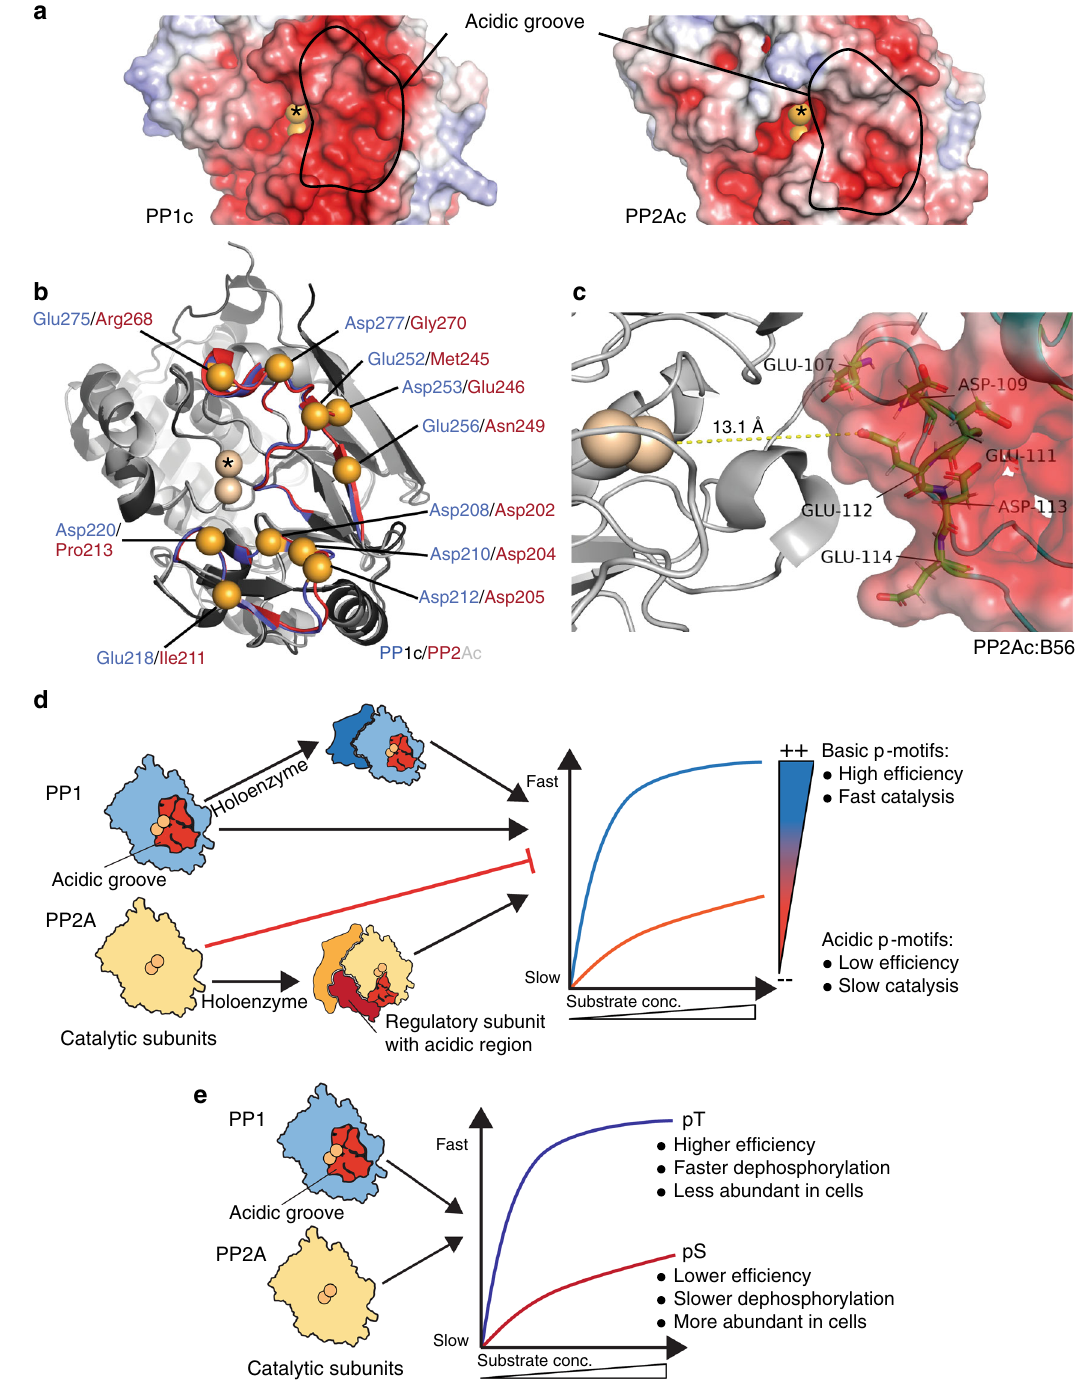
Fig. 8 Relating the amino acid preference of PP1c and PP2Ac to holoenzymes. a The acidic groove is much more pronounced in PP1c compared to PP2Ac. Structures for PP1 catalytic subunit alpha isoform (PDB ID 3EGG, chain A) 50 and PP2A catalytic subunit alpha isoform (PDB ID 4I5L, chain C) 69 were retrieved from www.pdb.org (accessed 25 Oct 2019) and inspected in PyMOL v2.3.3. * marks the catalytic cleft containing two Mn 2 + ions. Color coding between − 5 (red) to + 5 (blue) K b T/e . b Aligned structures of PP1c and PP2Ac (see above for details) highlighting residues which determine differences in acidic properties (orange spheres). The sequence alignment to determine corresponding residues was carried out in Needle (EMBOSS). Color coding of structures: PP1c in blue/black, PP2Ac in red/gray. Residues constituting the acidic groove have previously been de fi ned by Zhang et al. 70 c Interaction of PP2Ac with B56/B´/PR61 based on the crystal structure of the trimeric holoenzyme with the scaffolding subunit A (PR65) derived from PDB ID 2NPP 48 . Negatively charged amino acids within the binding regions of B56 to PP2Ac are highlighted. d The holoenzyme of PP1 has an intrinsic preference for basic motifs due to the composition of the acidic groove of the catalytic core protein. PP2A holoenzymes are per se not primed towards amino acid sequence features of 14-3-3 or PKA motifs, but need to associate to regulatory subunits such as B56 carrying acidic patches to achieve basophilic sequence speci fi city. e Both, PP1 and PP2A holoenzymes have a preference for pT due to a higher catalytic ef fi ciency of their respective catalytic subunits towards pT over